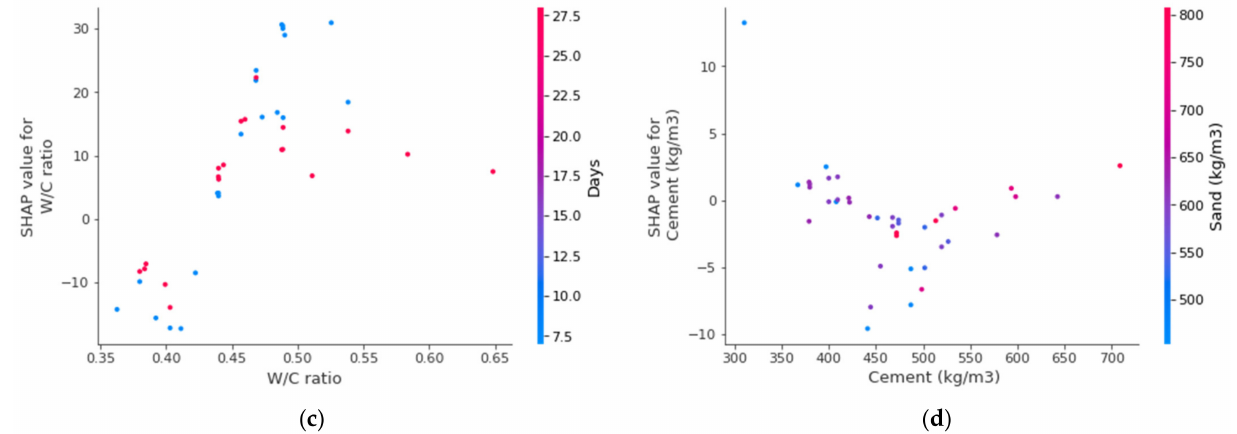
Figure 17. Interaction plots of various parameters: ( a ) marble dust; ( b ) days; ( c ) w/c ratio; and ( d )